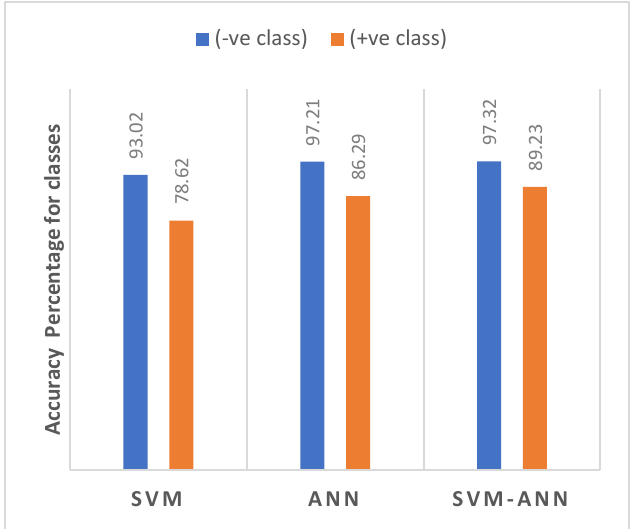
Figure 3. Class level Comparison of Accuracy.